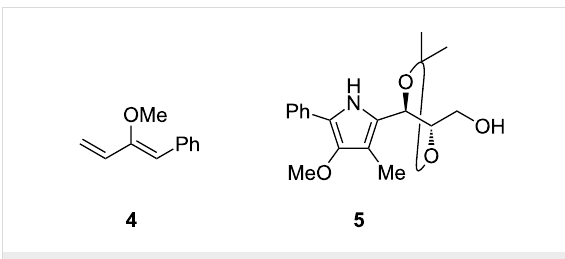
Figure 1: By-products 4 and 5 isolated from the reaction of nitrone 1a with lithiated methoxyallene.